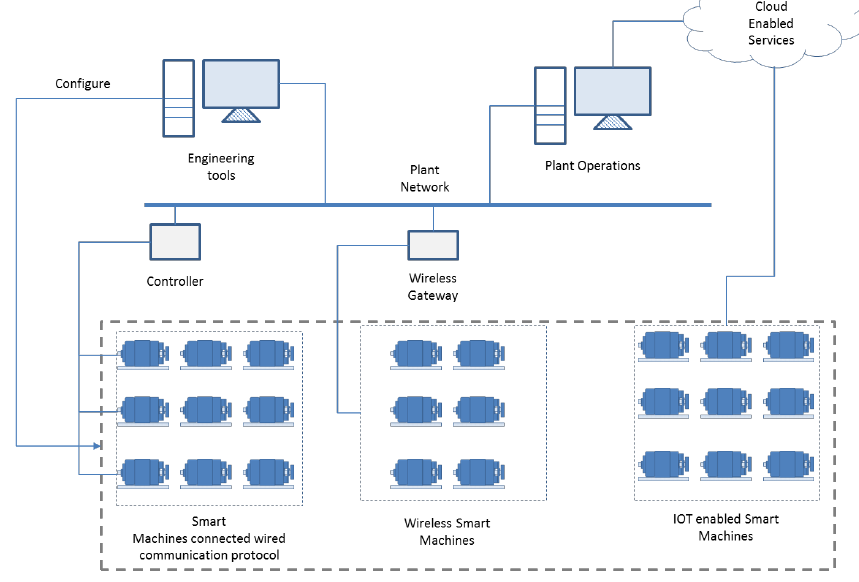
Figure 5. Plant-wide fleet condition